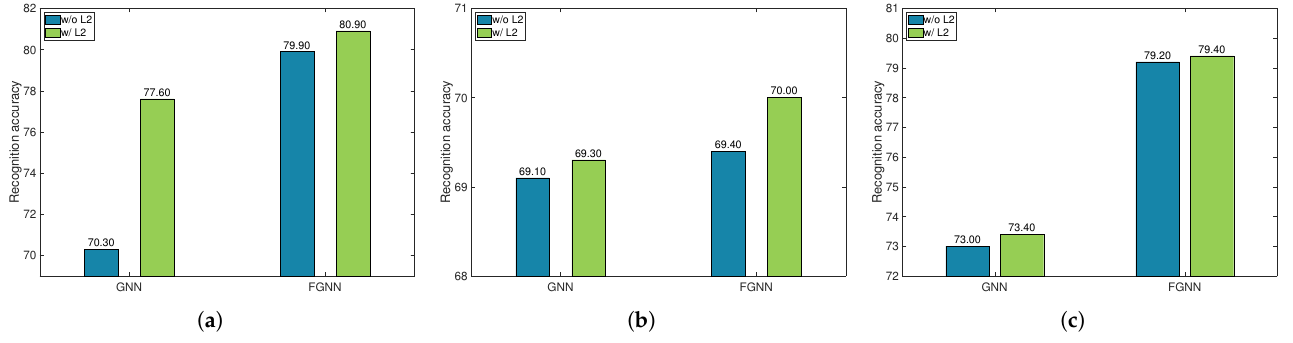
Figure 6. Testing recognition accuracy (%) of GNN and FGNN with or without L2 regularization on the citation network datasets ( a ) Cora, ( b ) Citeseer, and ( c ) Pubmed.